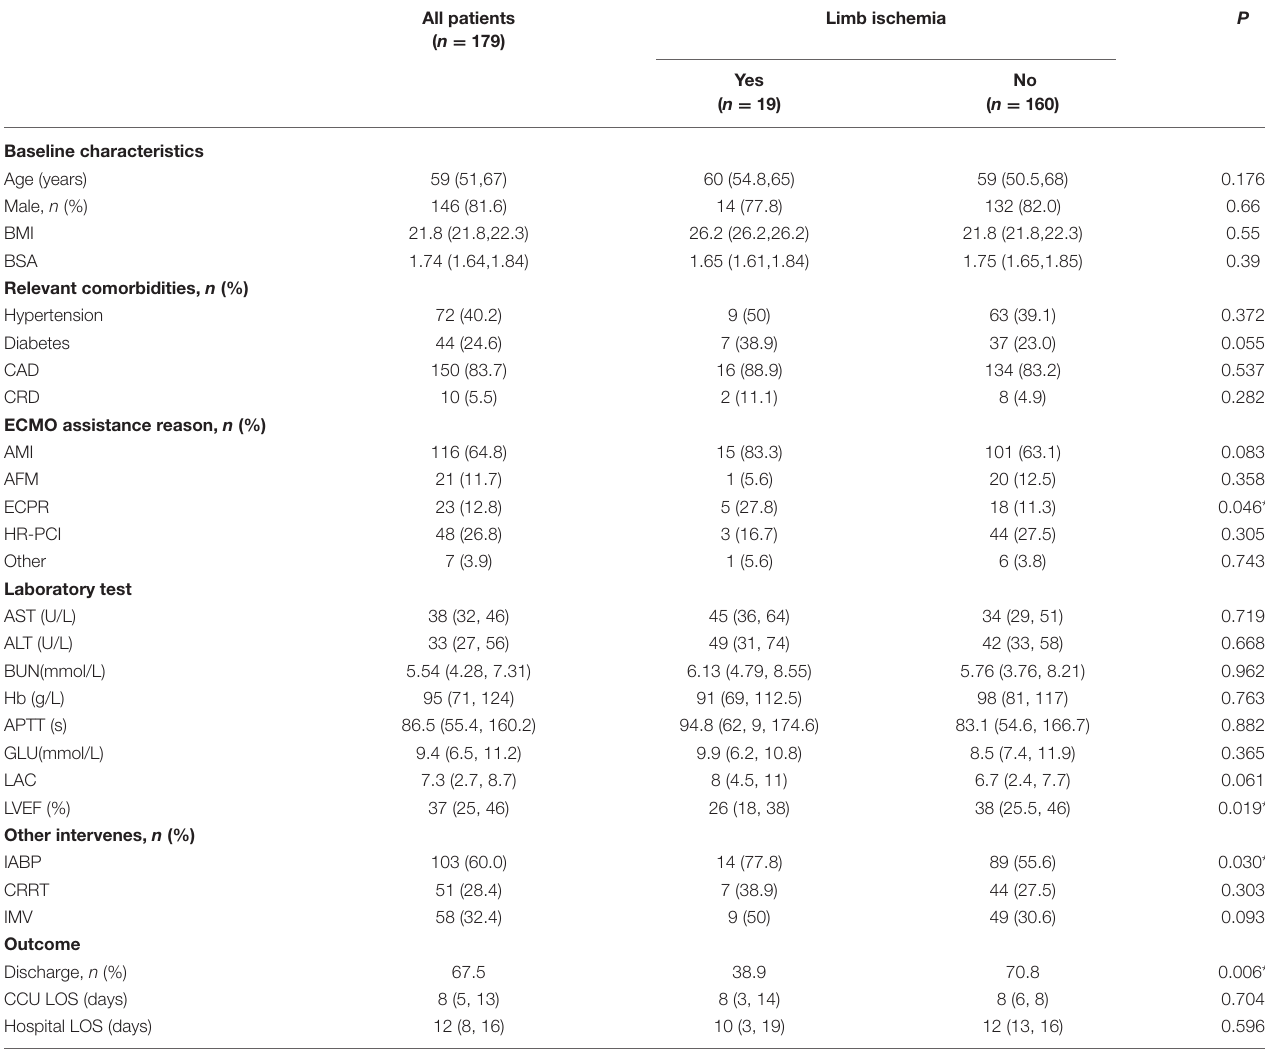
TABLE 1 | Comparison of baseline characteristics of patients.